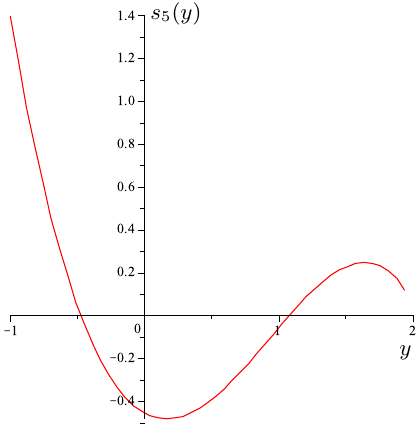
Figure 1 . Plot of s 5 ( y ) between the poles y = (cid:0) 1 and y =